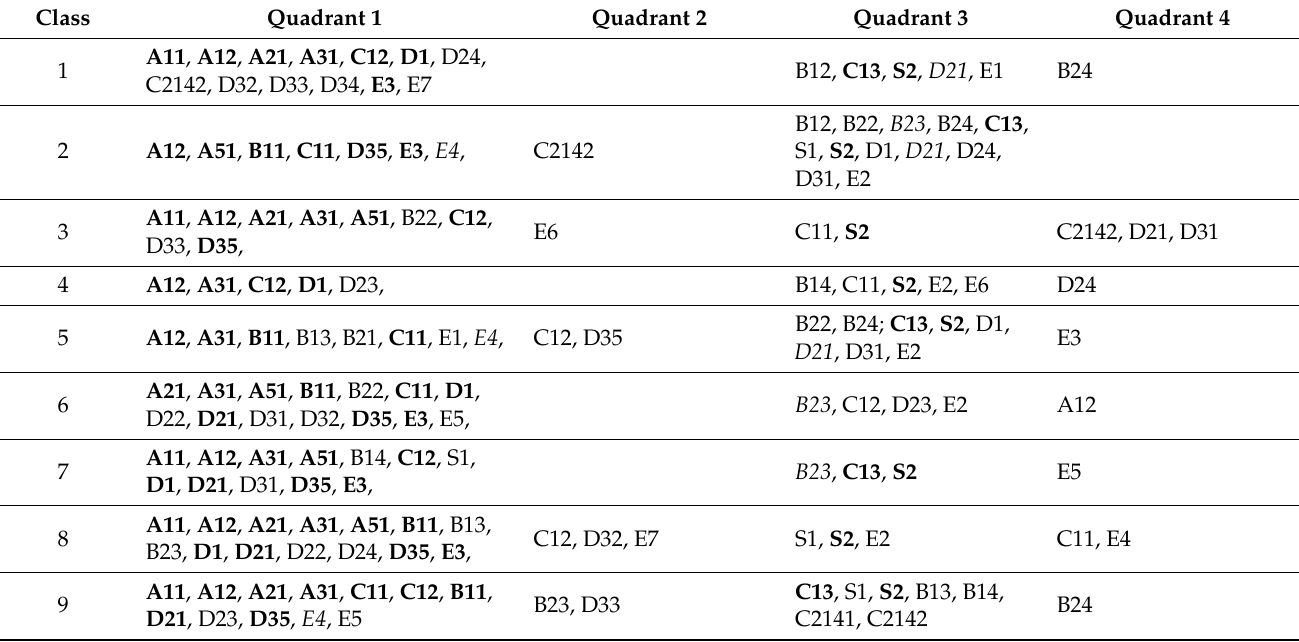
Table 11. Multiple cases: relating other people’s behaviors to their emotions (A41) as a focal behavior with category selection as conditioned behaviors.